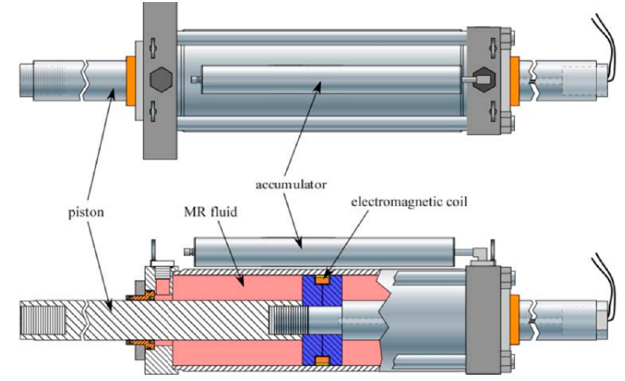
Figure 6. Schematic of the magnetorheological (MR) damper [74].